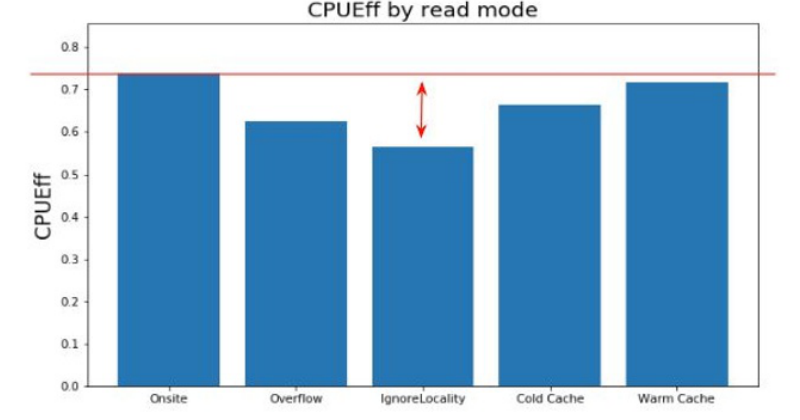
Warm Cache allows ​